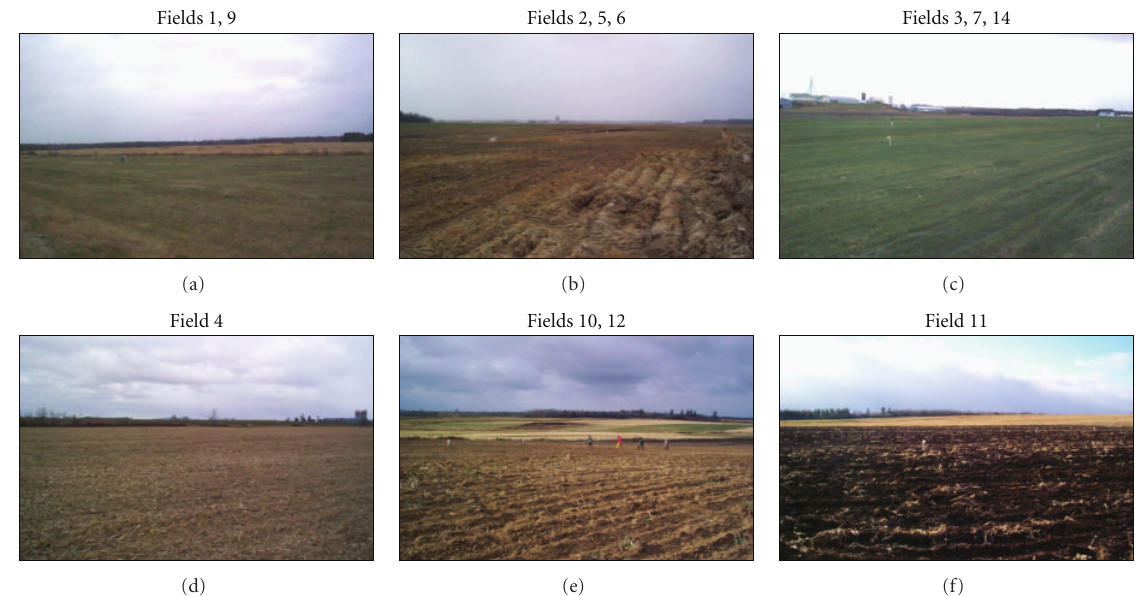
Figure 2: Photographs showing the types of land cover considered in this study: untilled fields (1, 3, 7, 9, and 14), tilled fields (2, 4, 5, 6, 10, 11, and 12).